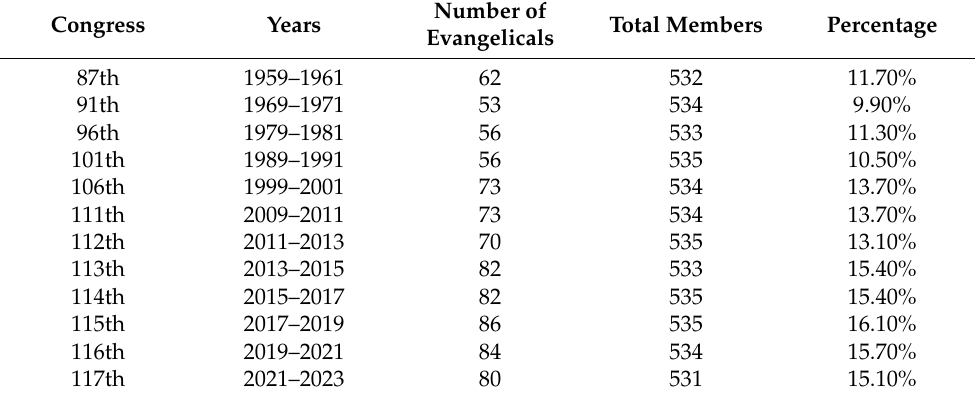
Table 2. Percentage of evangelicals in the US Congress